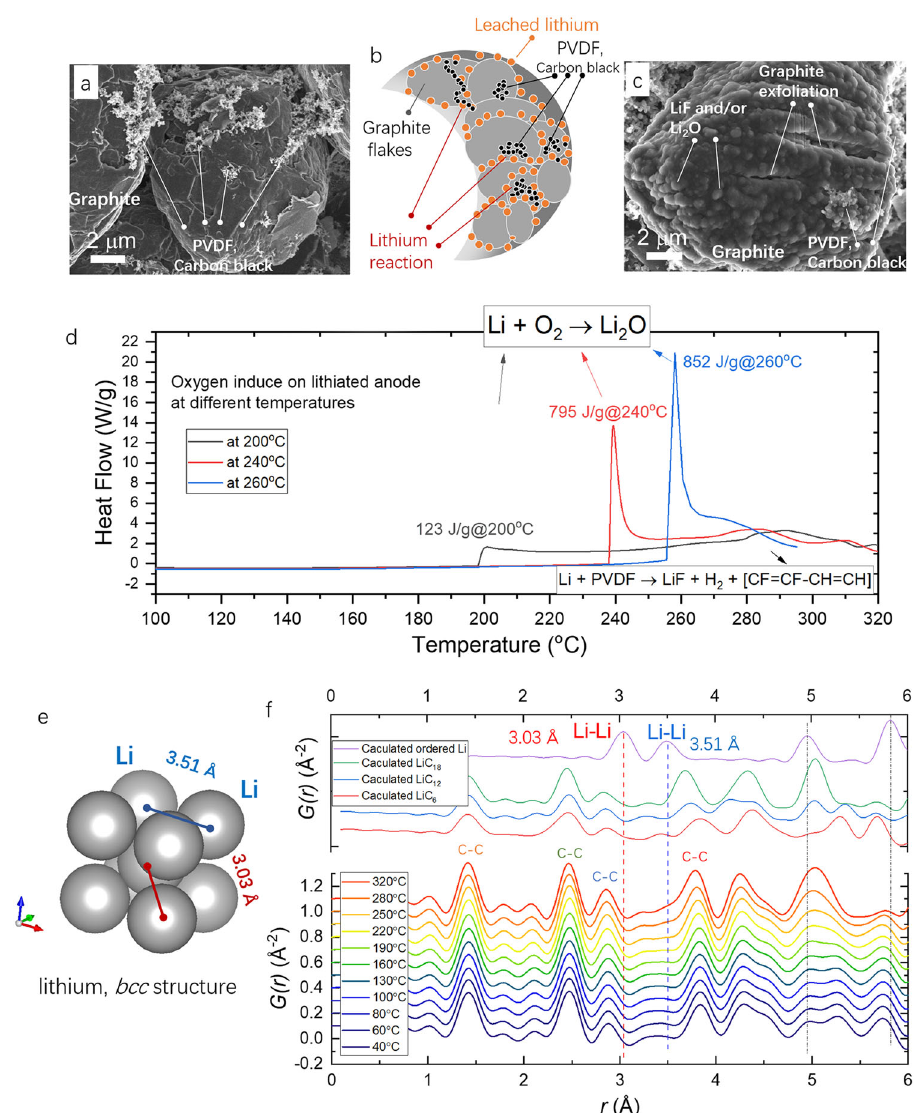
Fig. 4 The post-analysis and in situ PDF of the lithiated graphite anode. a SEM image of the graphite anode before heating. b An illustration of the lithium leaching and reaction process on the edges of graphite fl akes. c SEM image of the lithiated graphite anode after 280 °C heating. d The in fl uence of oxygen on lithiated graphite anode at different temperatures during the DSC measurements. e The illustration of lithium bcc atomic structure. f The in situ PDF analysis of the lithiated graphite anode during the